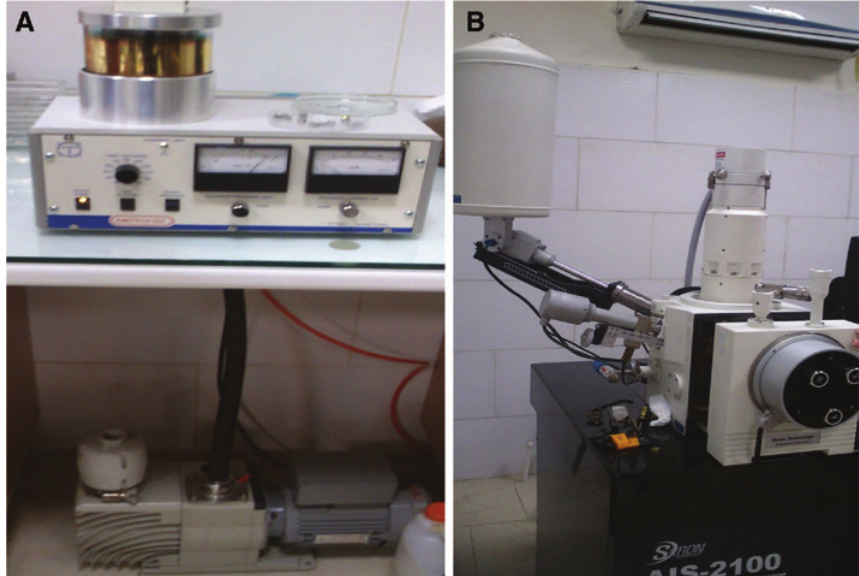
Figure 5: (A) Sputter coater (B) Scanning electronic microscope.